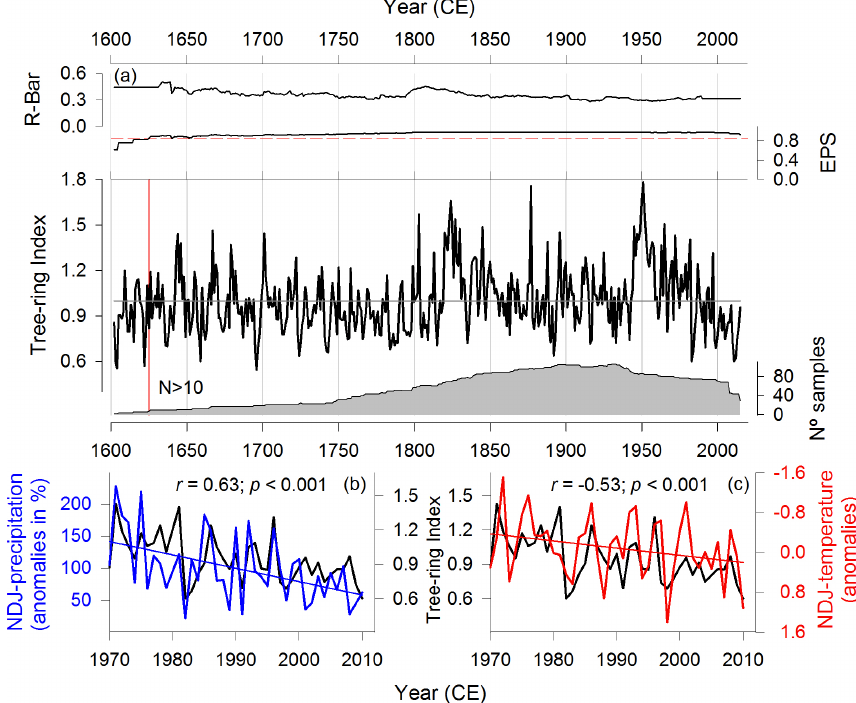
Figure 2. Regional tree-ring chronology and its relationships with climate variables. (a) Regional signal-free chronology of Polylepis tara- pacana for the northern South American Altiplano, the number of tree-ring series (gray shading), and R-Bar and EPS statistics for the period 1602–2015CE. The dashed horizontal red line represents the EPS 0.85 threshold. The vertical red line indicates the year since the chronology is represented with more than 10 ring-width series. Comparison between the inter-annual variations in the tree-ring chronology (black line) with (b) the regional precipitation index from November to January (NDJ; blue line) for the period 1970–2010 and (c) the regional NDJ temperature index (red line) for the period 1963–2010 for the northern South American Altiplano. The temperature is shown inversely to facilitate the comparison between records (right axis). The correlation coefficients and the slope trend and significance are indicated in each